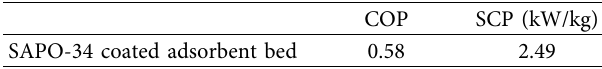
Table 4: Calculated COP and SCP for the SAPO-34 coated bed. COP SCP (kW/kg) SAPO-34 coated adsorbent bed 0.58